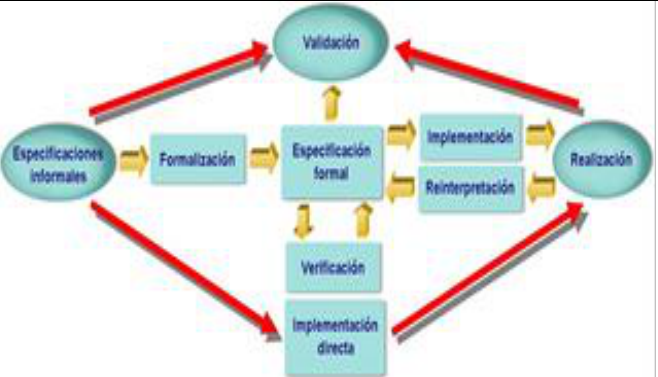
Figura 4: Fases del diseño formal de automatizaciones con PLCs. Fuente: